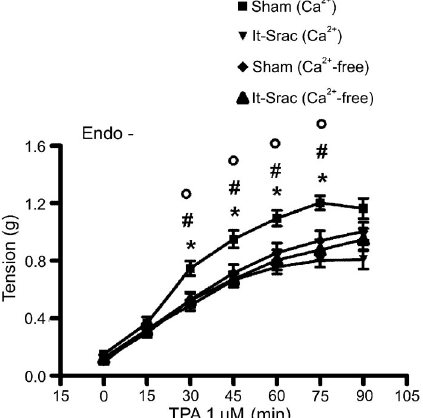
Figure 6. Contractile responses to 12- O -tetradecanoylphorbol 13-acetate (TPA) in rat thoracic aortas under pressure overload. TPA-induced contractions were developed either in a Ca 2++ -free solution (Ca 2++ -free) or a standard Ca 2++ -containing medium (Ca 2++ ) in endothelium-denuded (Endo-) aortic rings obtained from rats 8 weeks after suprarenal abdominal aortic coarctation (lt-Srac) or sham surgery (Sham). Data are reported as means±SE in grams of developed force as a function of time (min) (n=13-16). *P , 0.05, Sham (Ca 2++ ) vs lt-Srac (Ca 2++ ); # P , 0.05, Sham (Ca 2++ ) vs lt-Srac (Ca 2++ -free); 6 P , 0.05, Sham (Ca 2++ ) vs Sham (Ca 2++ -free) (two one-way ANOVA with the Bonferroni post hoc